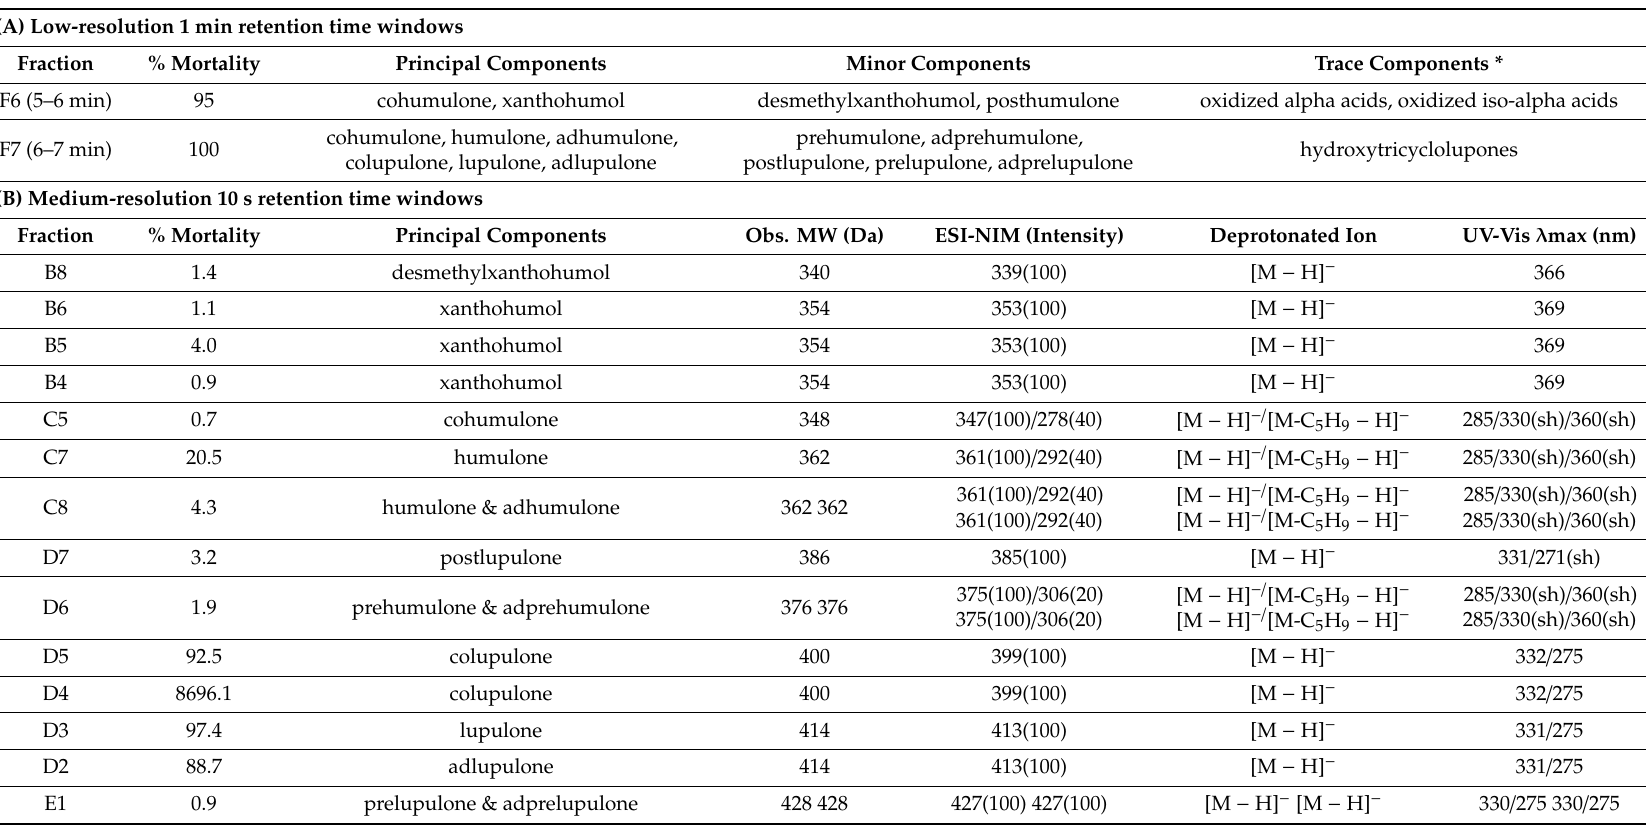
Table 1. Principal bioactive compounds from Hops ( Humulus lupulus L.) identified through UMSF. ( A ) Low-resolution 1 min retention time windows; ( B